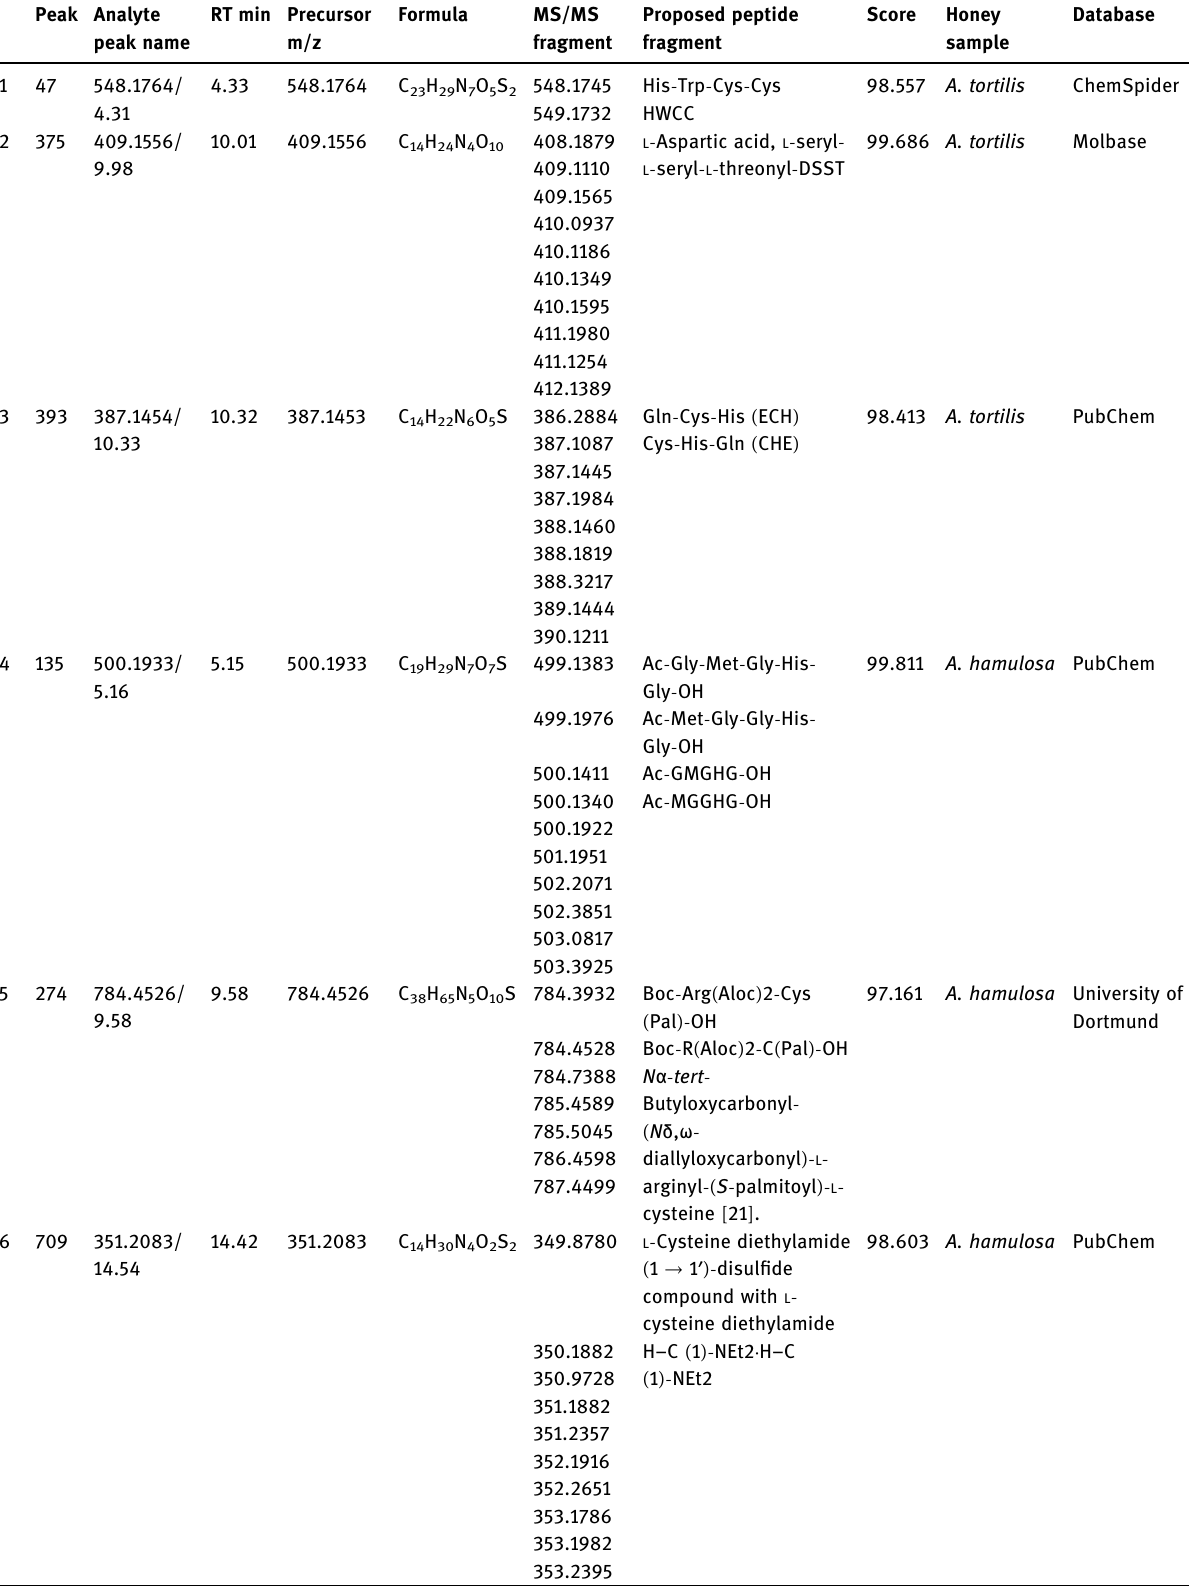
Table 2: The short and cyclic peptides of the Acacia and Ziziphus honey samples Peak